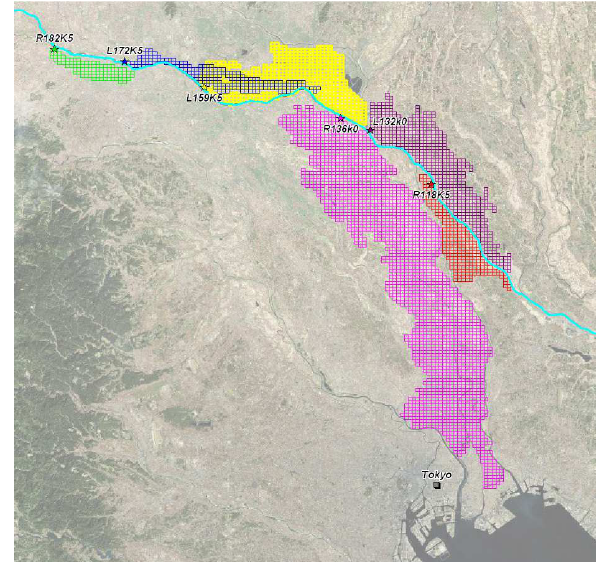
Fig 4: Flood extents of the selected scenarios in this study: Red: R118k5, Yellow: L159k5, Green: R182k5, Pink: R136k0, Purple: L132k0 and Blue: L172k. Stars: Levee-break points, Gray Square: Central Tokyo, Light blue line: Tone River (L172k5 and L159k5 partially overlap) (adapted from Tone River Upstream Office, National and Regional Planning Bureau).